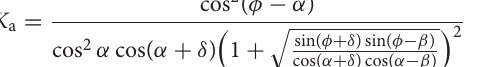
TABLE 1 | Loadcases for the example wall. LC 1 LC 2 LC 3